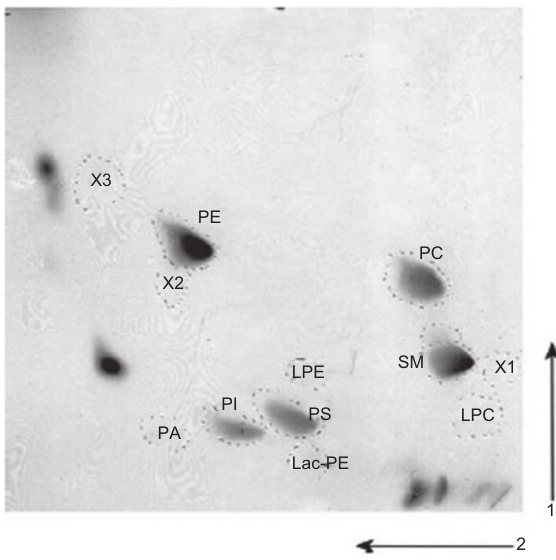
were outlined and labeled. Solvent systems, 1st direction: chloroform- -benzene (65:30:6:10, by vol.), 2nd direction: methanol-28 % aq. NH 3 chloroform-ethyl acetate-acetone-2-propanol-absolute